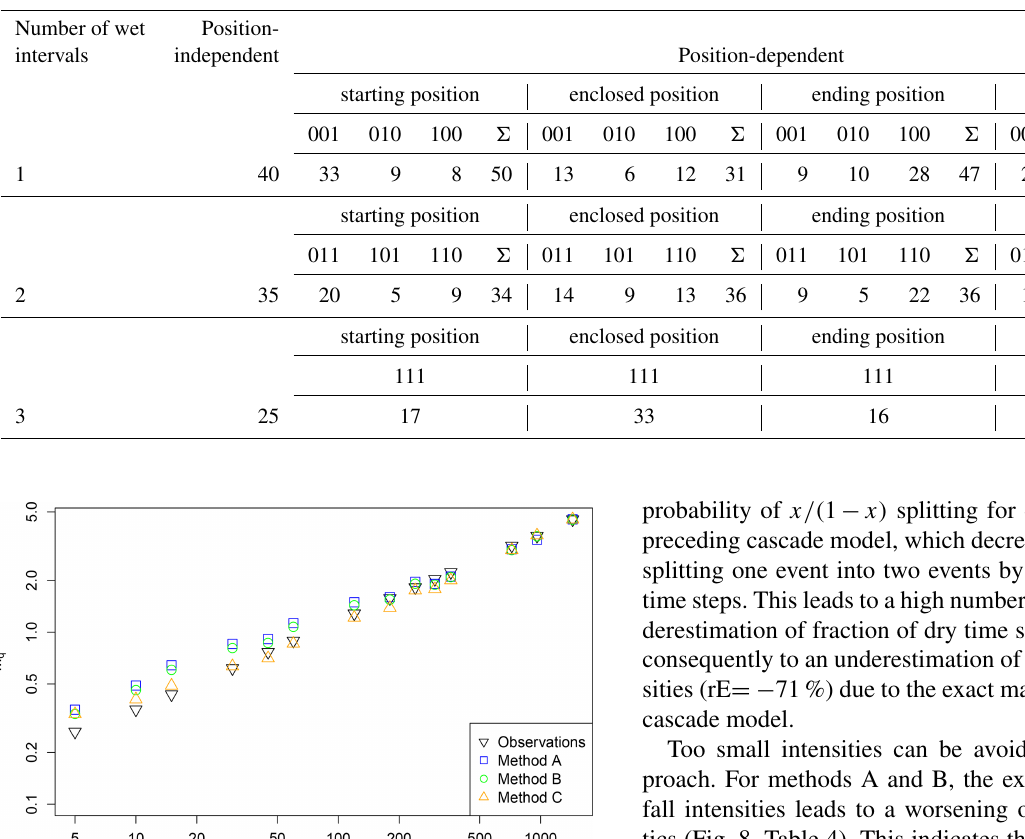
Table 3. Position-dependent and position-independent probabilities for one, two and three wet 8h intervals in the uniform splitting (mean of all 24 stations for the lower volume class, all values in percent – %). The combination of “1” (wet) and “0” (dry) illustrates the order of wet and dry 8h intervals in a day.